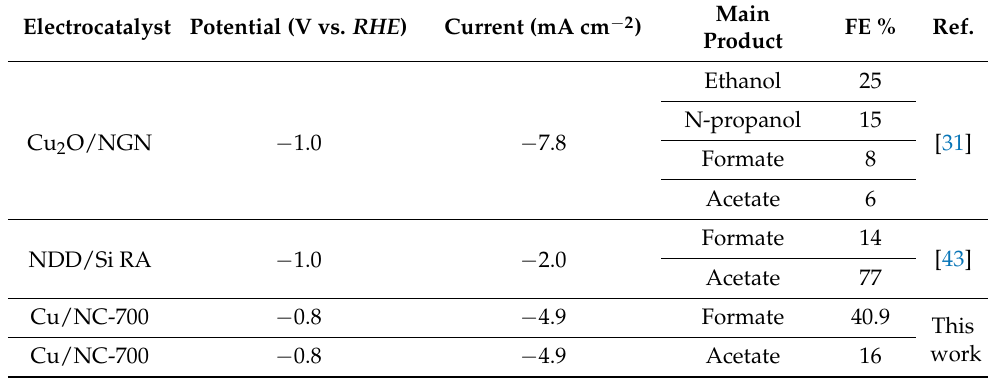
Table 1. Cont. Electrocatalyst Potential (V vs. RHE ) Current (mA cm − 2